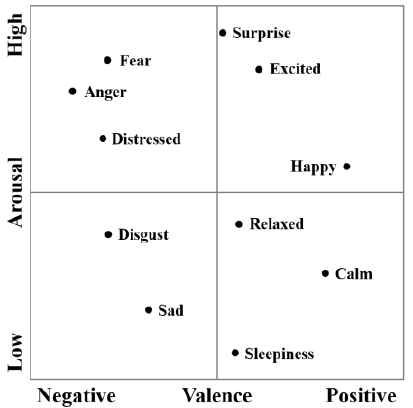
Figure 2. Two-dimensional emotion model [55]